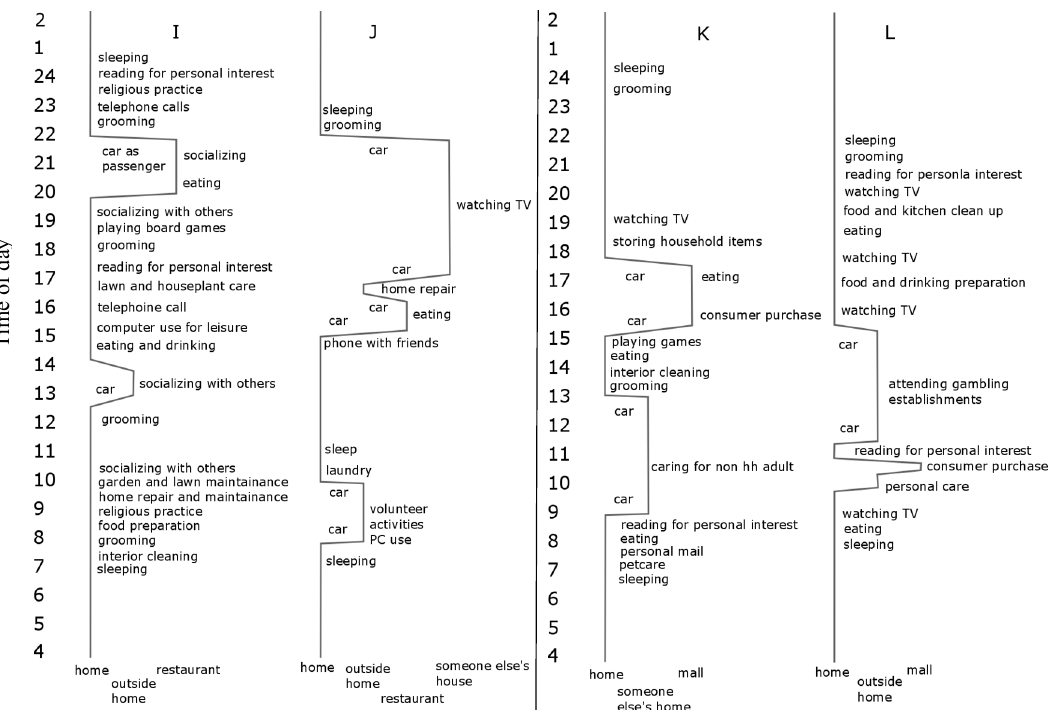
Figure 6. Activity pattern of two sample retired individuals with travel time equal to the average for age 60–75 (I&J) and age >75 (K&L). The Y axis represents time of day. The Y -axis represents time of day, starting from early morning at the bottom and time running upward by hour. The vertical length of a line is the duration of an activity. A discrete X axis represents location of an activity (hh = household), the left-hand vertical line is home, vertical lines to the right of this are workplace, restaurant, or other location. Slanted lines refer to travel between locations.